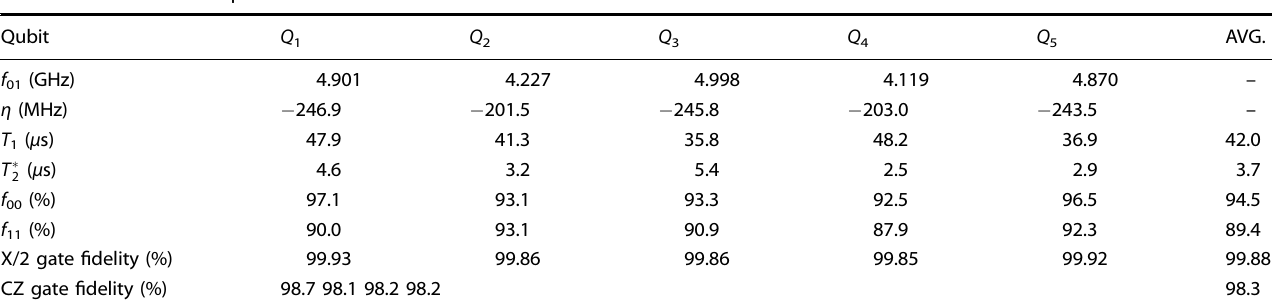
Table 2. Performance of